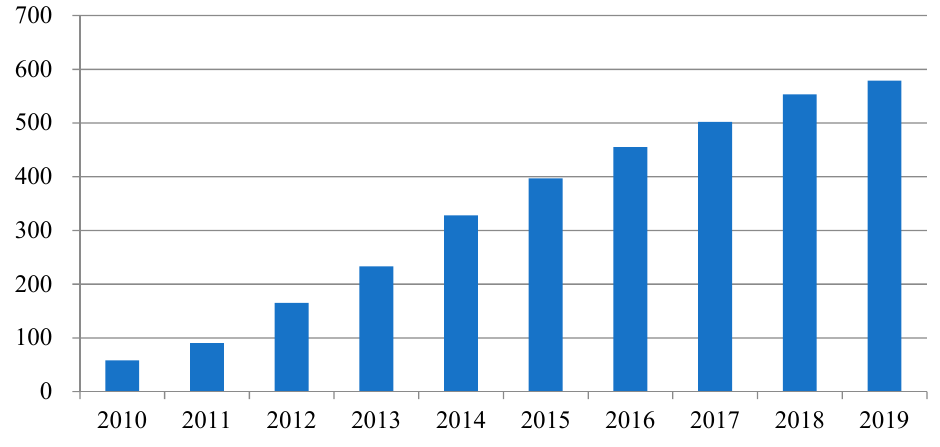
Figure 3. Number of samples from 2010 to 2019.